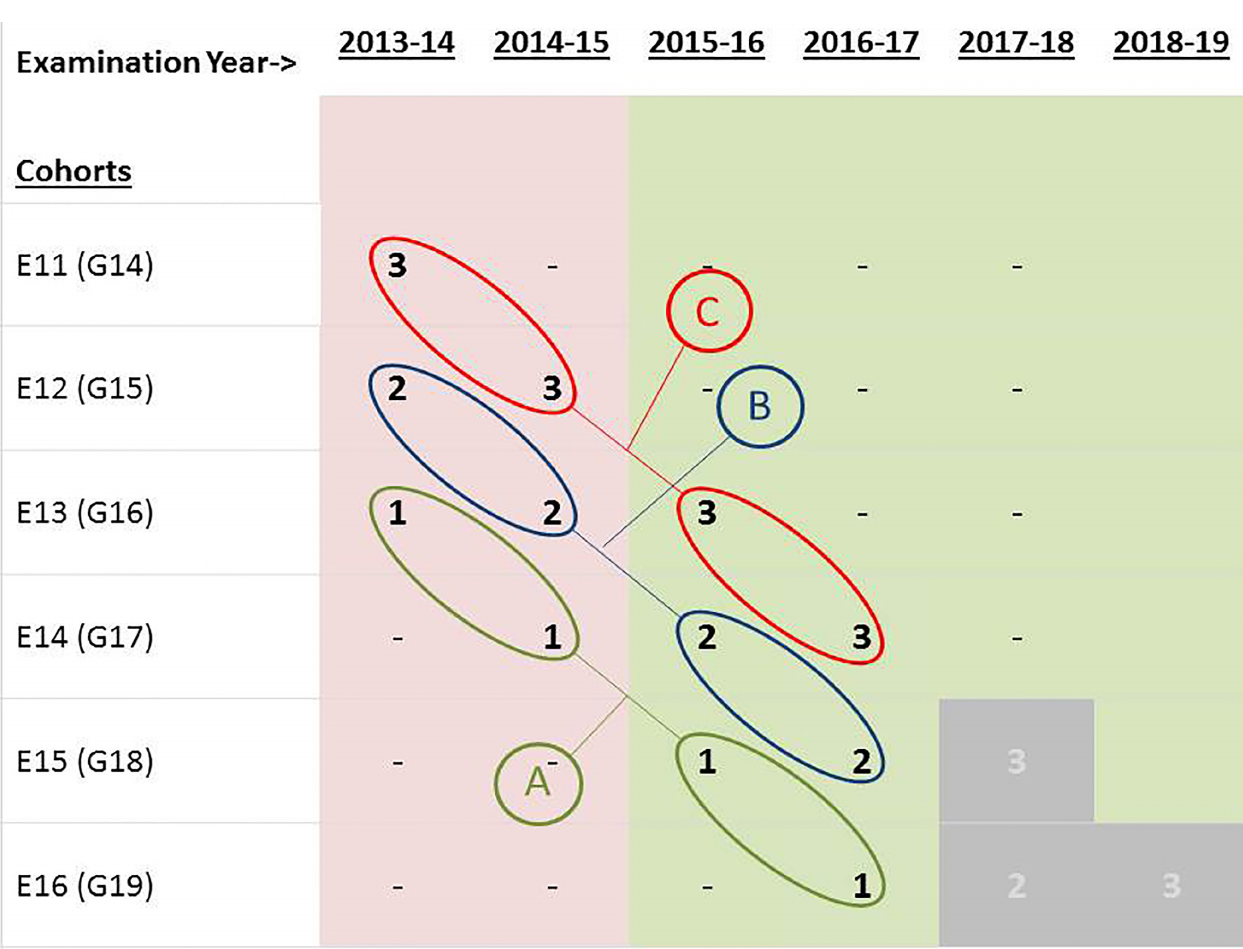
Figure 1. Comparison cohorts for in-training examination